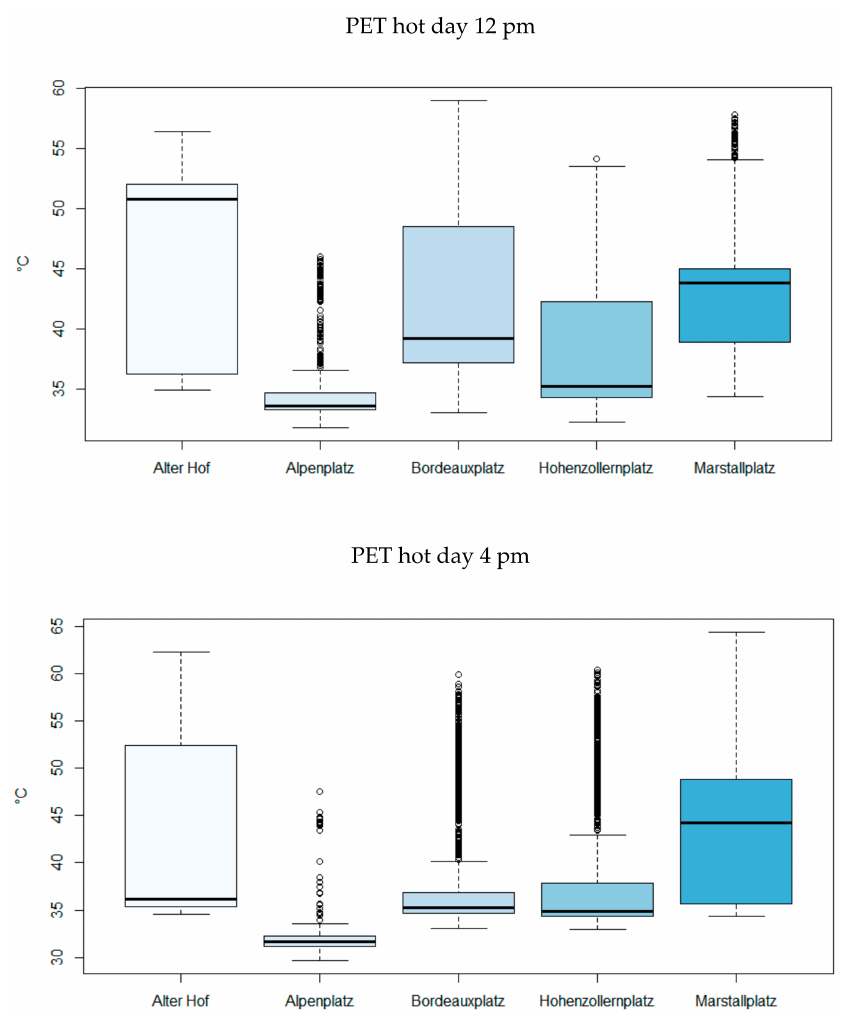
Figure 12. PET values for the hot day at critical hours (12 pm and 4